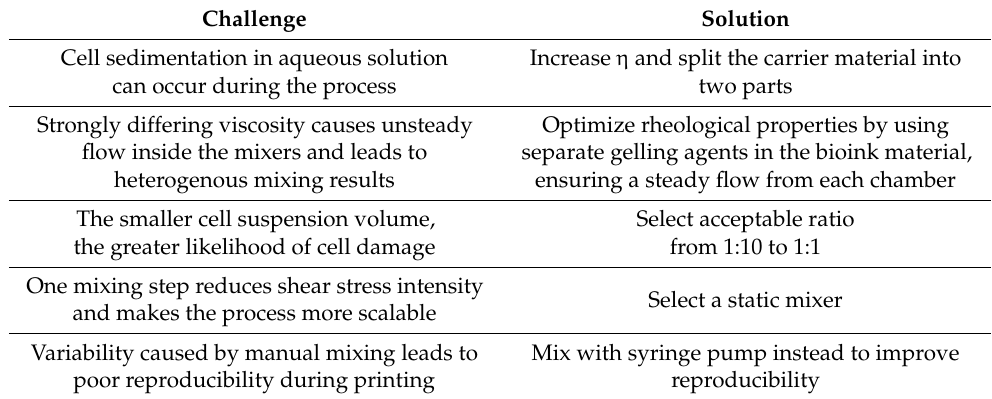
Table 2. Requirements profile for the optimization of the mixing process with cells for bioprinting. Challenge Solution Cell sedimentation in aqueous solution Increase η and split the carrier material into can occur during the process two parts Optimize rheological properties by using Strongly differing viscosity causes unsteady separate gelling agents in the bioink material, flow inside the mixers and leads to ensuring a steady flow from each chamber heterogenous mixing results The smaller cell suspension volume, Select acceptable ratio the greater likelihood of cell damage from 1:10 to 1:1 One mixing step reduces shear stress intensity Select a static mixer and makes the process more scalable Variability caused by manual mixing leads to Mix with syringe pump instead to improve poor reproducibility during printing